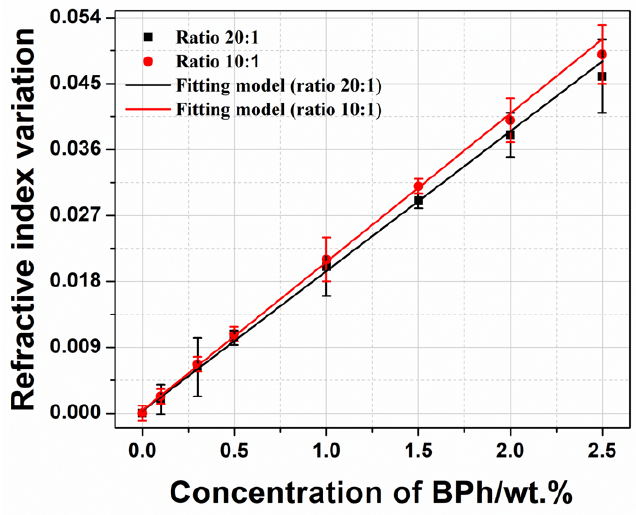
Figure 1. Variation of the refractive index of PDMS-BPh as a function of the concentration of BPh in wt.%. Solid lines represent the fitting model of Equation